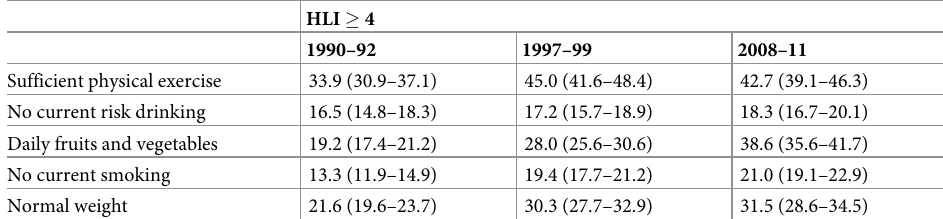
Table 2. Proportion (%, 95%-CI) of each health behaviour factor by healthy lifestyle index (HLI) �